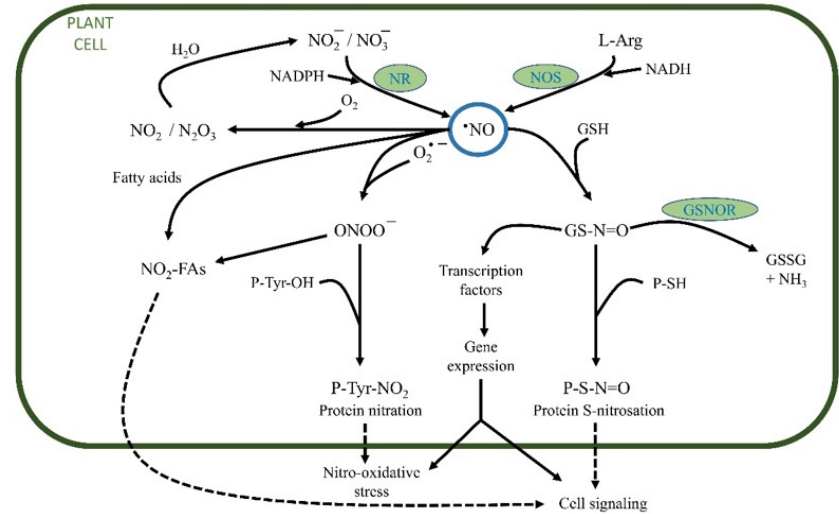
Figure 4. Metabolism of · NO in plant cells. · NO can be produced by nitrate reductase (NR), L-Arg NO synthase (NOS), or other reductive processes. · NO can react by S-nitrosation with glutathione (GSH) to form S-nitrosoglutathione (GS-N=O). GS-N=O can be converted by S-nitrosoglutathione reductase (GSNOR) into oxidized glutathione (GSSG) and NH 3 . As part of the signaling process, the protein sulfhydryl groups can react with GS-N=O and other S-nitrosothiols to produce S-nitrosated proteins (P-S-N=O). Peroxynitrite (ONOO − ) is an oxidant obtained by interacting · NO with O 2 · − . The NOOO − can mediate the nitration of proteins (P-Tyr-NO 2 ) and fatty acids (NO 2 -FAs). · NO in the presence of O 2 is transformed into N 2 O 3 and NO 2 , which are subsequently transformed into NO 2 − and NO 3 − in aqueous media. Modified from [40].